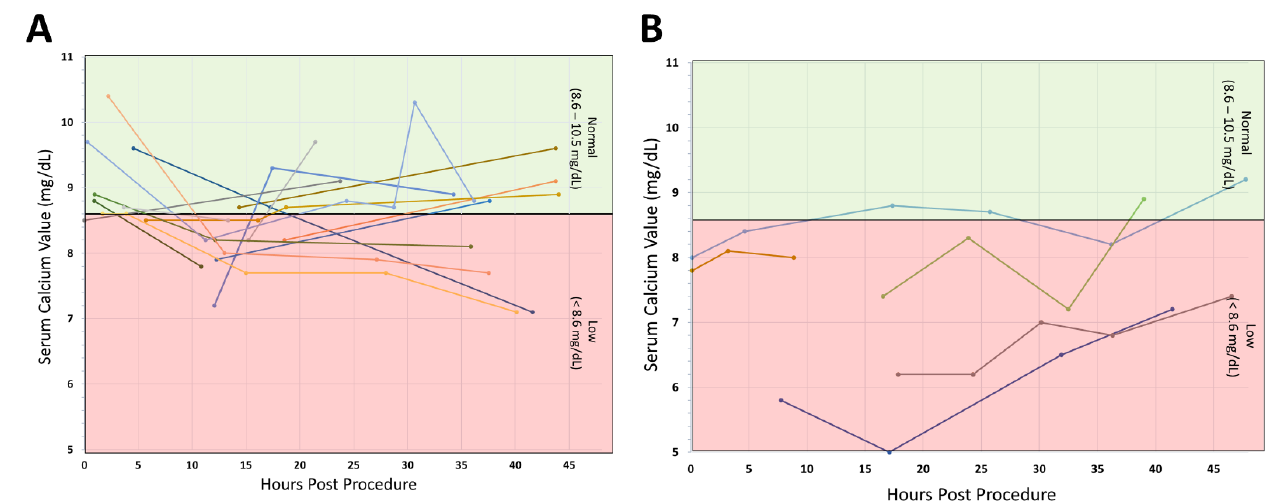
Figure 2. Serum Calcium Levels Recorded within 48 h of Surgery. For individuals who had >1 serum calcium testing recorded, we looked at trajectories of serum calcium levels and if or when levels returned to normal. ( A ) Individuals who were observed conservatively and not recommended any postoperative calcium supplementation. ( B ) Individuals who were recommended some type of postoperative calcium supplementation.